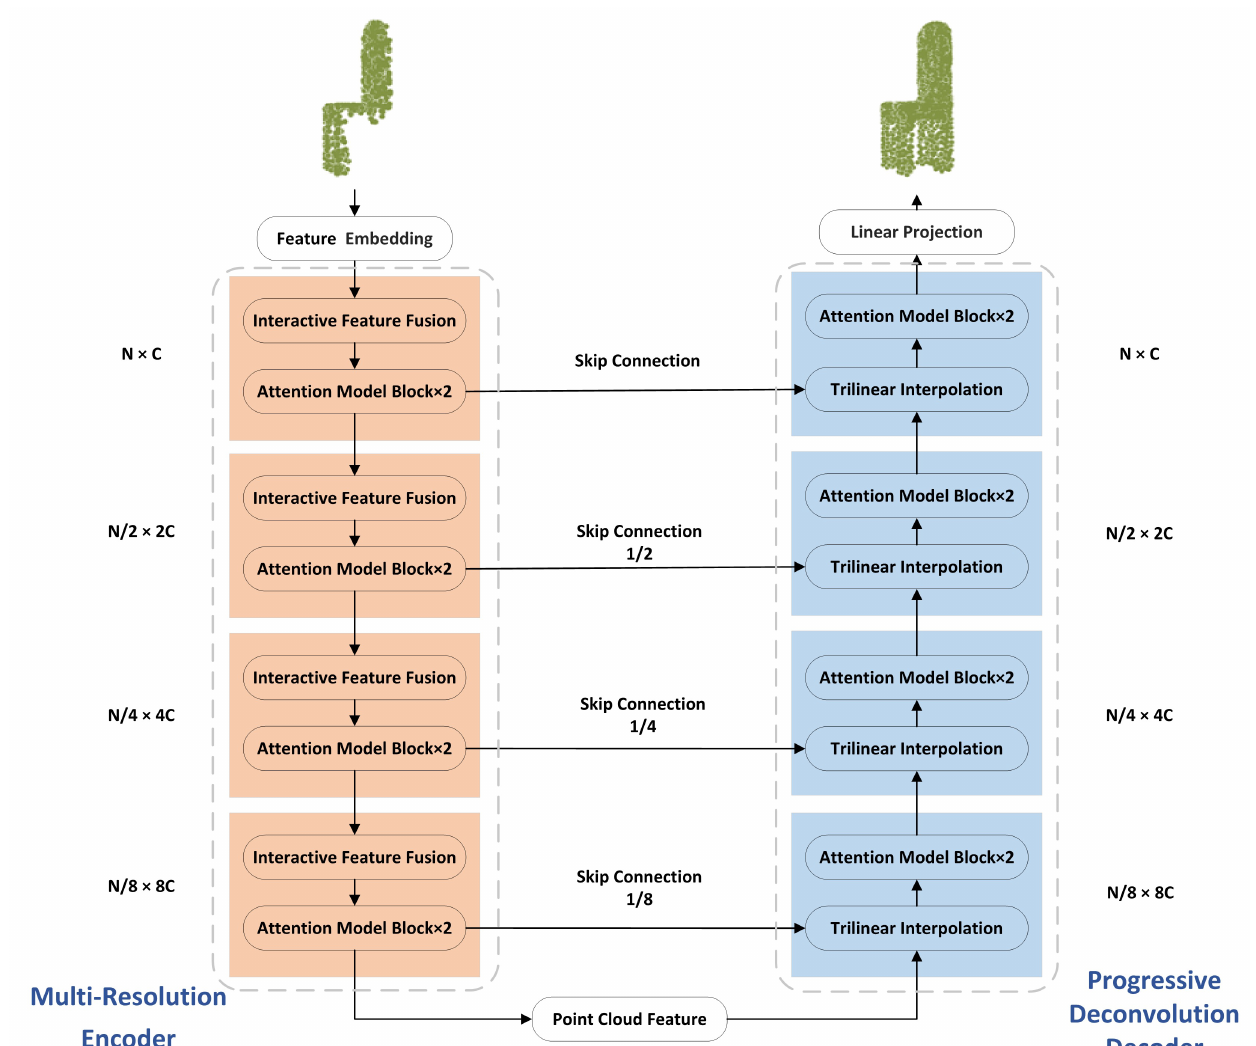
Figure 2. Network framework of PCA-Net. The input to PCA-Net is a missing point cloud, and the point cloud features are extracted using multi-resolution encoder (Section 3.1), including interac- tive feature fusion (Section 3.1.1) and attention model (Section 3.1.2). The extracted point cloud feature is used to generate high-quality complete point clouds by progressive deconvolution decoder (Section 3.2), including trilinear interpolation (Section 3.2.1). Linear projection represents features